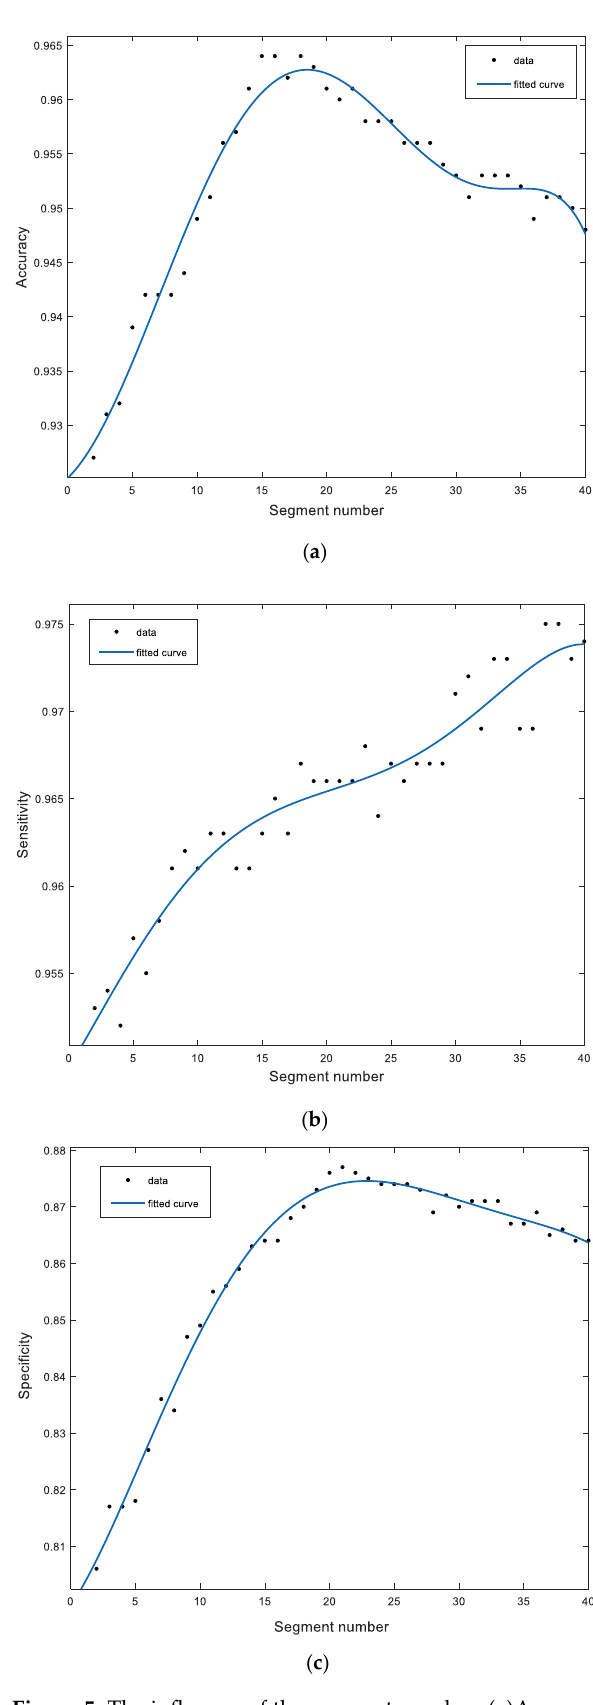
Figure 5. The influence of the segment number. ( a )Accuracy; ( b ) Sensitivity; ( c ) Specificity.